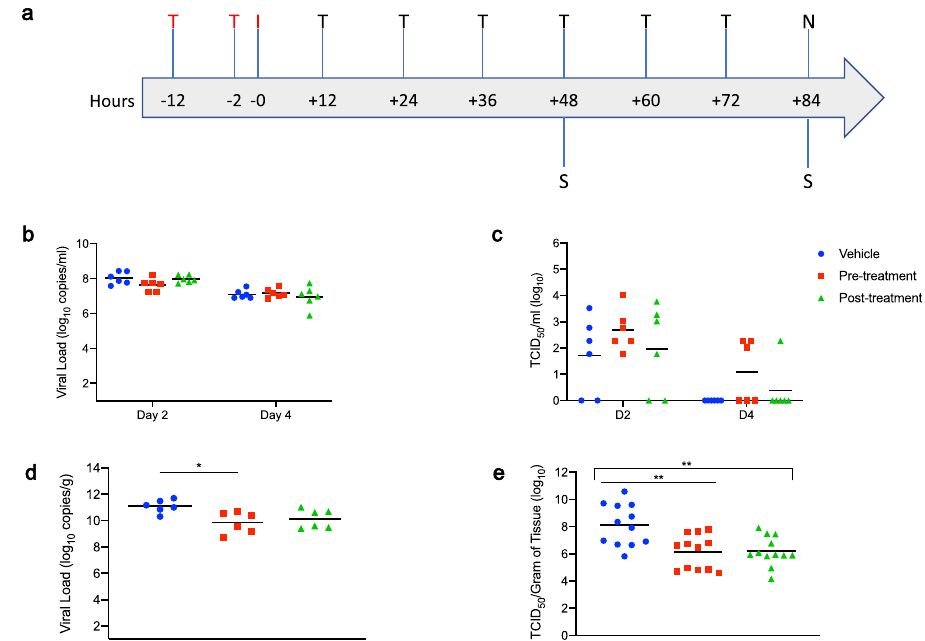
Fig. 2 Syrian hamster model — study design, viral shedding, viral load, infectious titers, and viral antigen. a Hamsters were intranasally infected with SARS-CoV-2. MK-4482 was administered pre-infection at 12 and 2 h before infection, or post-infection starting 12 h post-infection. Treatment was continued in both groups every 12 h for 3 consecutive days. Animals were euthanized on day 4 and lungs were harvested. T = treatment (red: pre-infection and black: post-infection treatments); I = infection; S = swab samples and N = necropsy. b Oral swab samples ( N = 6 per group) were collected on days 2 and 4 post-infection and viral shedding determined by RT-PCR ( p Value Vehicle vs Pre-treatment = >0.9999, p Value Vehicle vs Post-treatment = >0.9999, One-way ANOVA, Kruskal – Wallis test). c Oral swab samples ( N = 6 per group) were titered for infectious virus (TCID 50 ) on Vero E6 cells